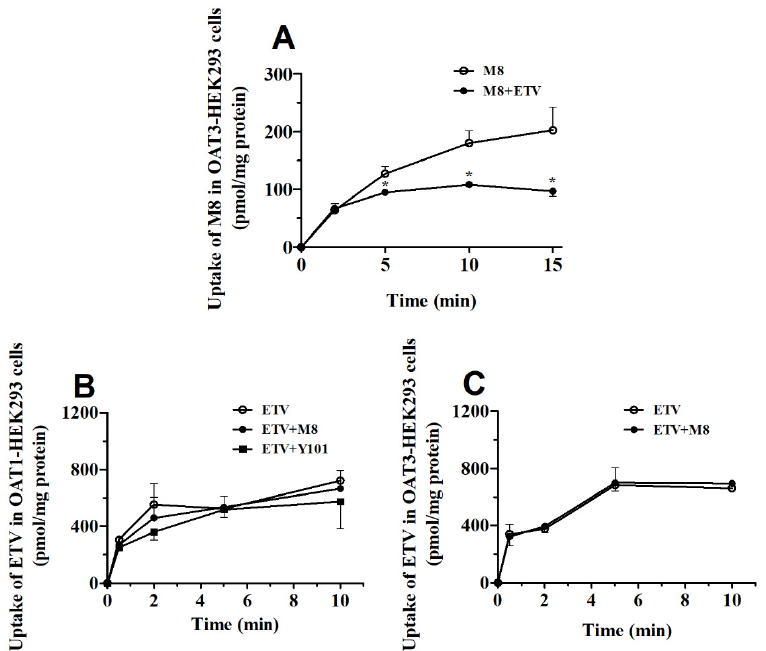
Figure 11. The DDI between Y101 (2.0 µM), M8 (10 µM) and ETV (10 µM) in hOAT1 ( B ) and hOAT3-HEK293 cells ( A , C ). *, p < 0.05 vs. M8-alone group. Data are expressed as mean ± SD, n = 3.